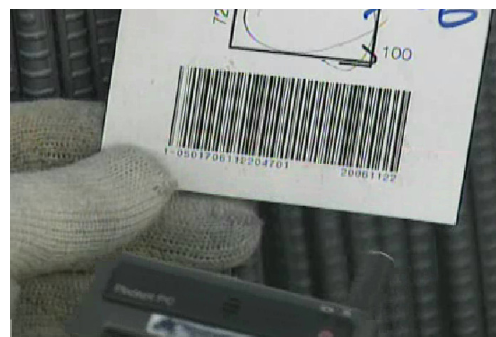
Fig. 14. Checking the materials using the PDA